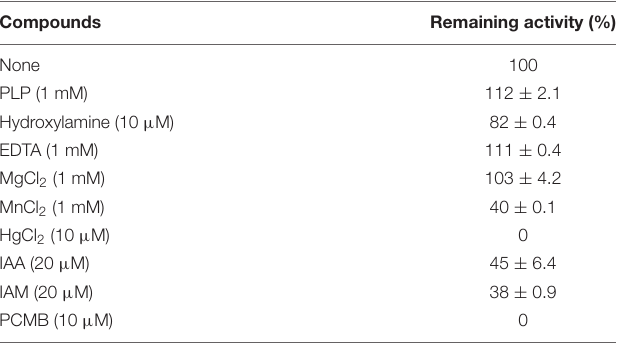
TABLE 1 | Inhibitory effect of various compounds on PddB activity. TABLE 2 | Kinetic parameters of PddB.